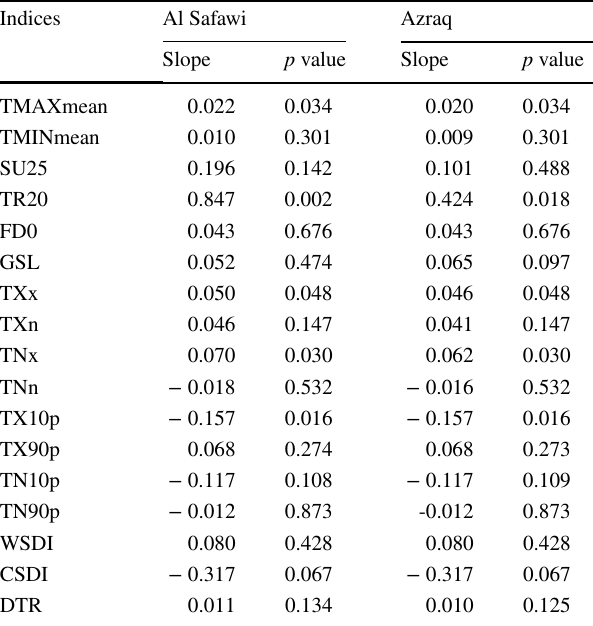
Table 4 Annual linear trends of the extreme climate indices of air temperature over the study area ( p value < 0.05)